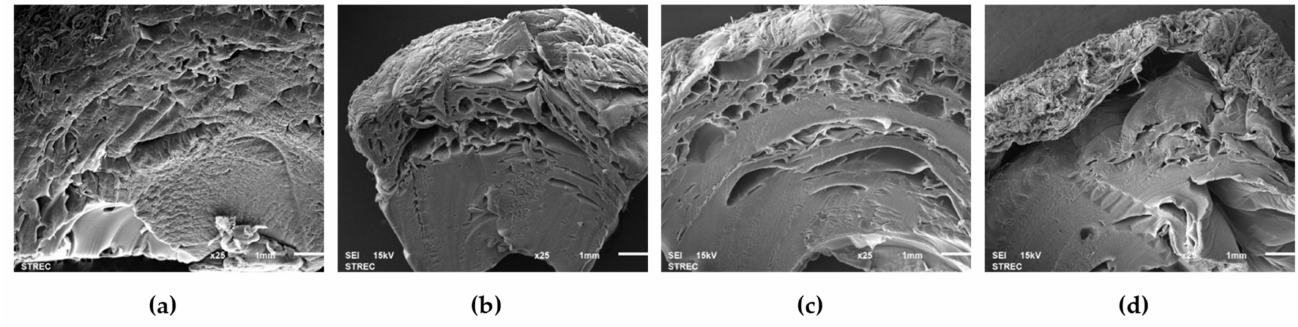
Figure 5. SEM images of the cross-sectional structures of the calcium-alginate hydrogel balls as affected by different working pressures for 3 cycles at 25 × magnification (1 cycle of control = 60 min of soaking during the external gelation process, while 1 cycle of PVS = 10 min of depressurization and 10 min of vacuum liberation for 3 repetitions (60 min)): ( a ) control, P = 101 kPa; ( b ) PVS, P = 61 kPa; ( c ) PVS, P = 35 kPa; and ( d ) PVS, P = 8